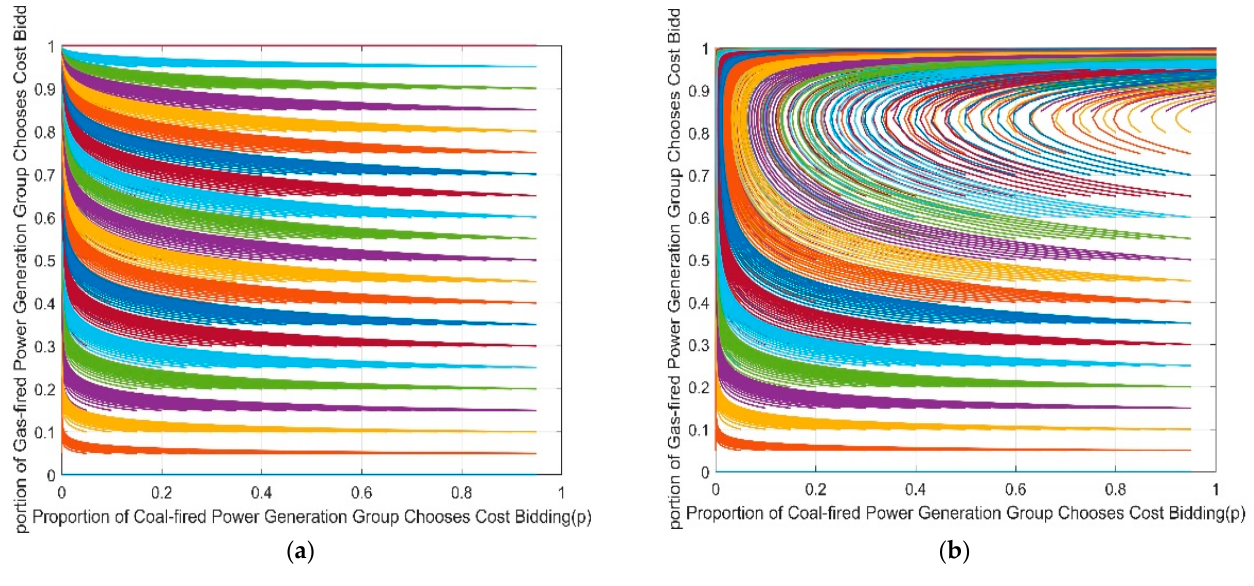
Figure 9. Evolution trend of bidding entities in phase 2 under scenario 2. ( a ) Simulation results of the evolution of gas-fired electricity cost in July 2020 and March 2021 when it is slightly higher than coal-fired electricity cost, ( b ) To reduce the price of electricity can increase the amount of gas-fired generators feed-in bids, the evolutionary simulation results at this point.